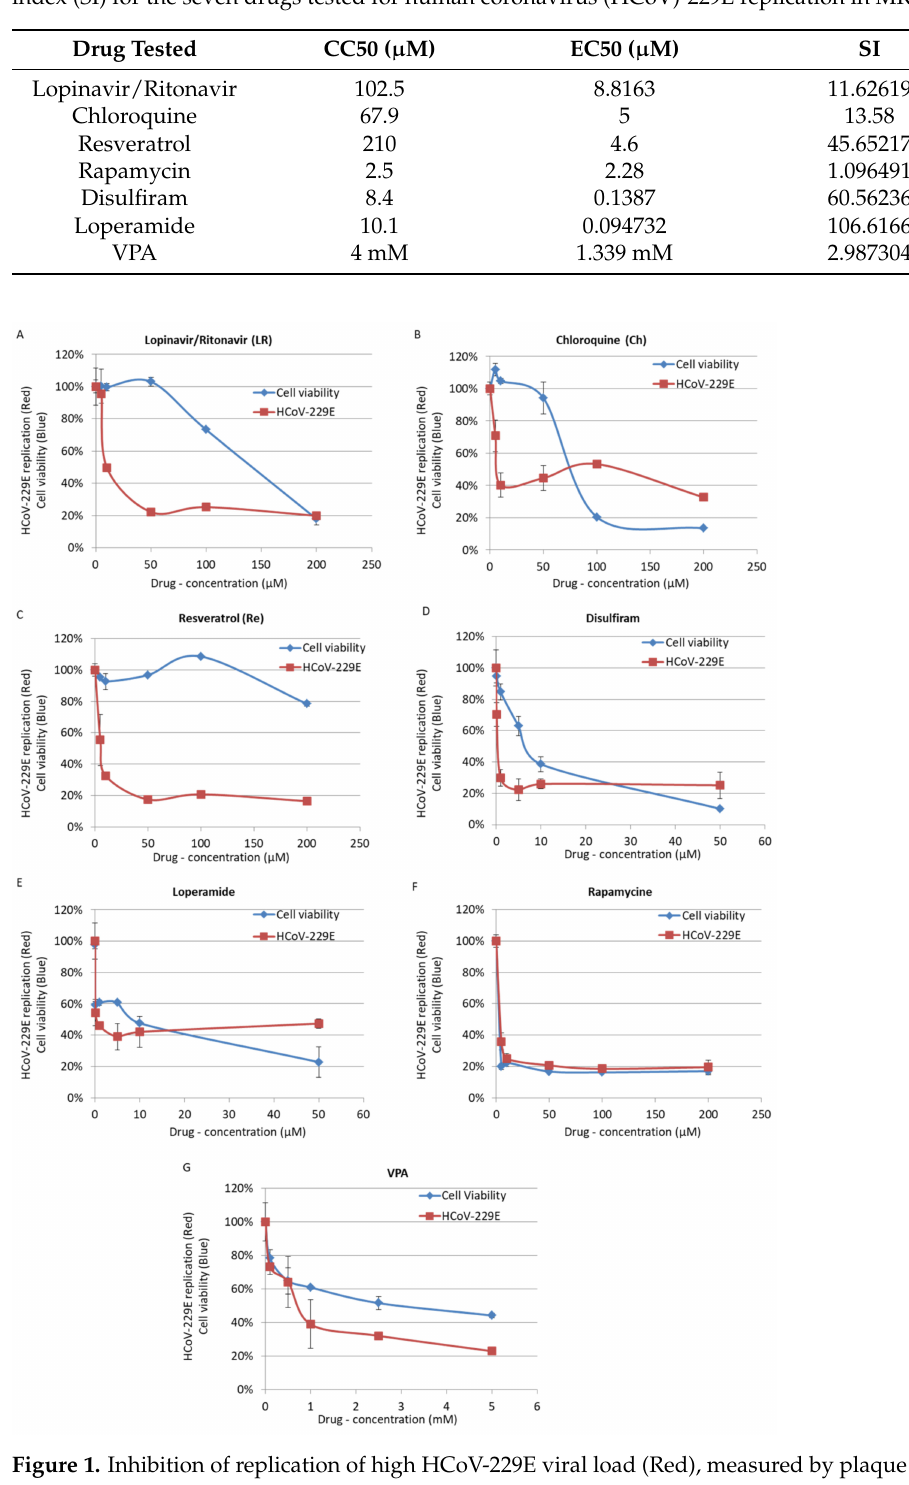
Figure 1. Inhibition of replication of high HCoV-229E viral load (Red), measured by plaque forming unit (PFU) assay, coupled with MTT toxicity assay (Blue) for Lopinavir/Ritonavir ( A ), Chloroquine ( B ), Resveratrol ( C ), Disulfiram ( D ), Loperamide ( E ), Rapamycin ( F ) and valproic acid (VPA) ( G ). Cells were treated by compounds at the time of infection with HCoV-229E (1 multiplicity of infection (MOI)). PFU and MTT assays were performed after 48 h. Uninfected cells were used for normalization of MTT assay. Untreated cells infected with HCoV-229E were used for normalization of PFU